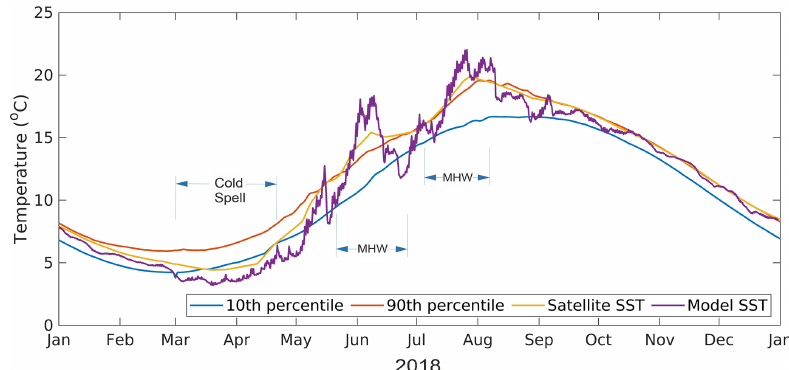
Figure 4. Annual SST variation (in ◦ C) at the NSB III platform in 2018. In addition to the satellite measurements (yellow curve) and the simulation results (purple curve), the 10th and 90th percentile SSTs from the multiyear statistics are shown. One cold spell and two MHWs were detected based on the 10th and 90th percentiles.